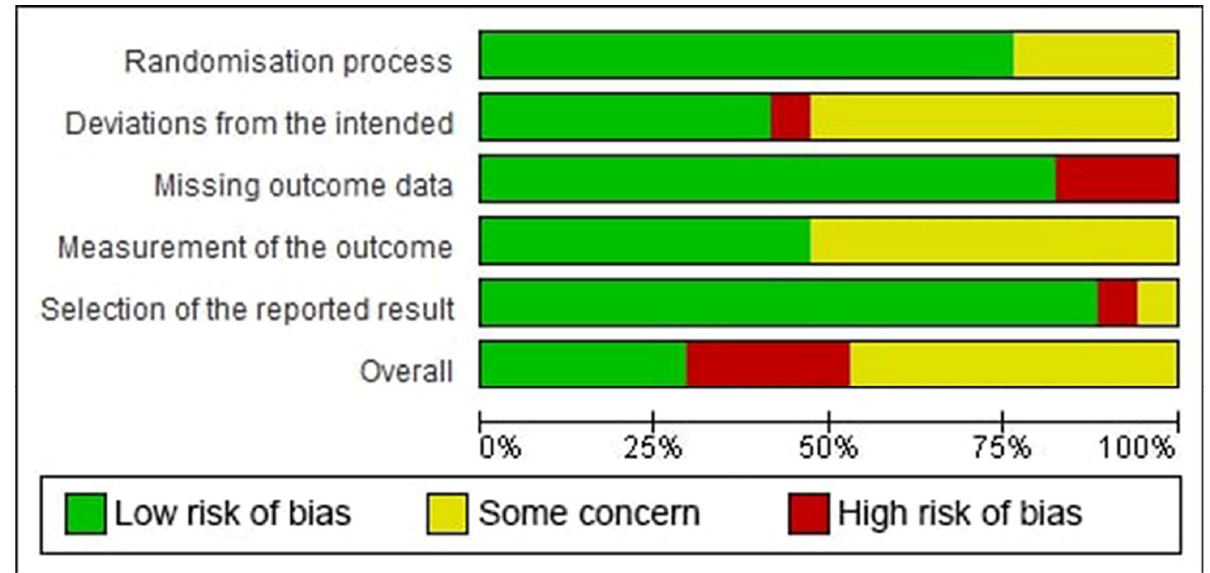
Figure 2. Risk-of-bias graph: the authors’ judgments for each risk-of-bias item in the studies included, provided in percentage form.